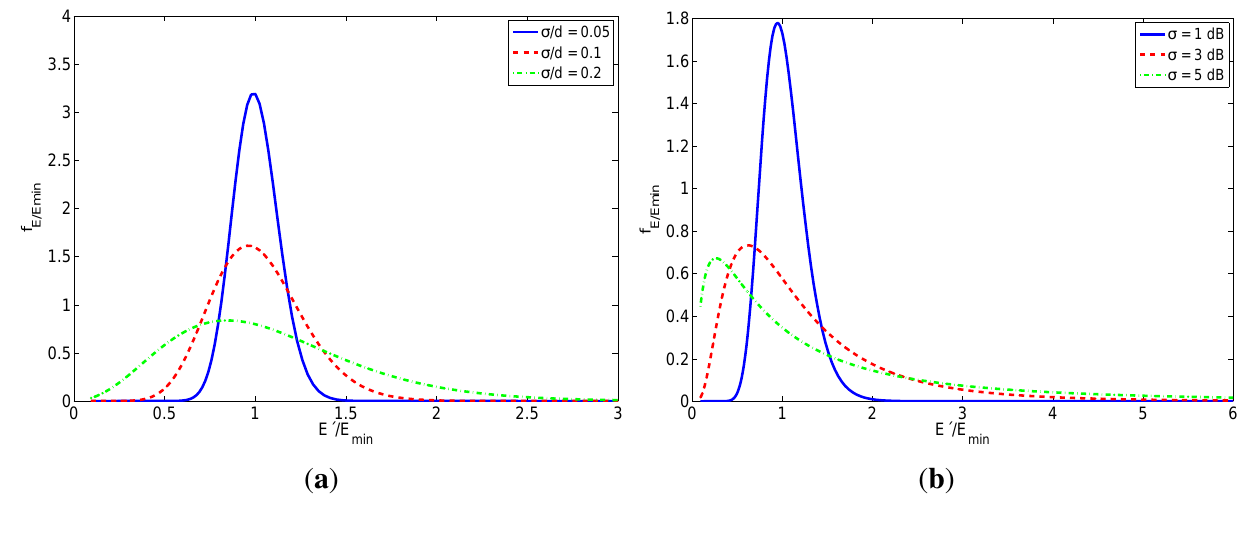
for TOA-based and RSS-based min